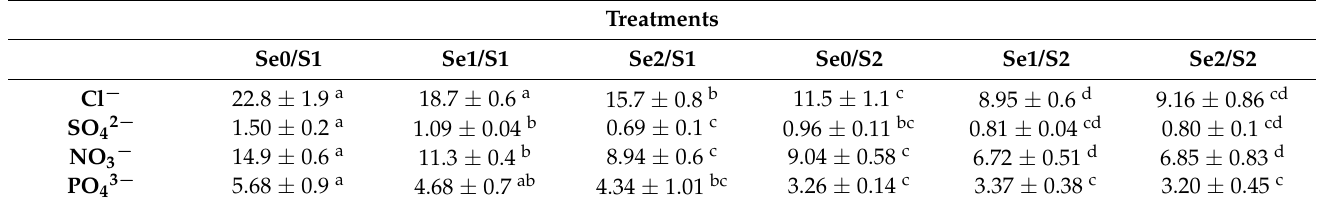
Table 3. Inorganic anions concentrations in the lettuce plants grown in a hydroponic system and treated with two S levels (S1: 1 mM; and S2: 2 mM (K 2 SO 4 )), and three Se levels (Se0: 0 µ M; Se1: 1.3 µ M; and Se2: 3.8 µ M (Na 2 SeO 4